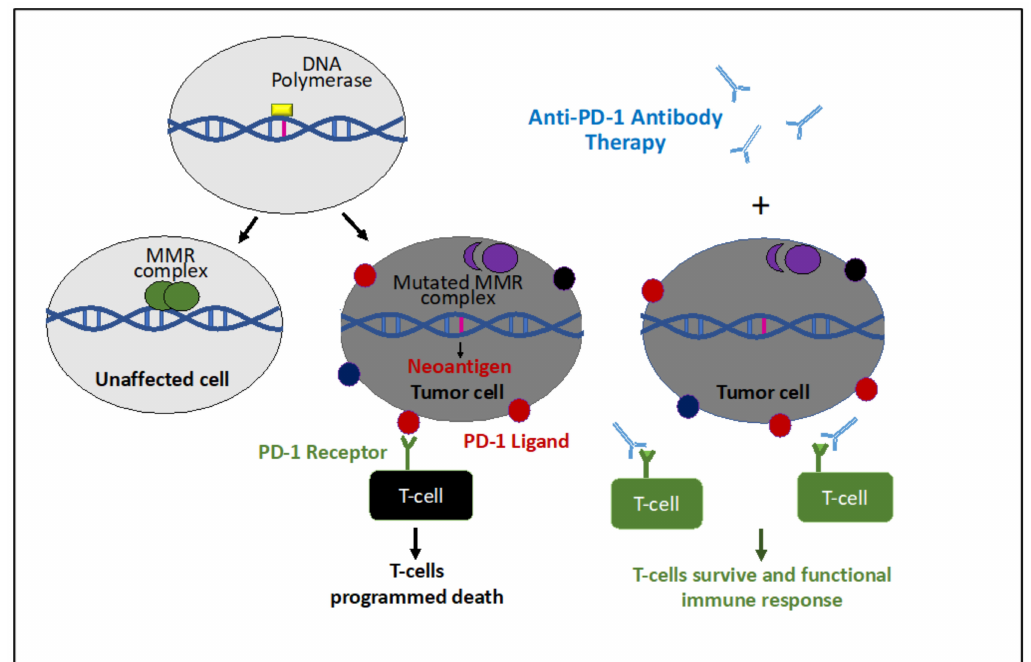
Figure 3. Illustration of e ff ect of the anti-programmed cell death-1 (anti-PD-1) antibody used for treatment of MSI / MMR gynecological cancer: In human cells the DNA polymerase can slip and insert or delete nucleotides at the repetitive DNA sequences, such as microsatellites. If these replication errors are not repaired by the repair machinery due to a defective MMR, it can lead to MSI. Translation of such genes with MSI can result in creation of novel peptide sequences, such as neoantigens (e.g., PD-ligands). Thus, these ligands on the tumor cell can trigger cell death of T cells and so evade an immune response. The anti-PD-1 antibodies bind programmed cell death-1 (PD-1) receptor and can prevent activation of programmed cell death by the PD-1